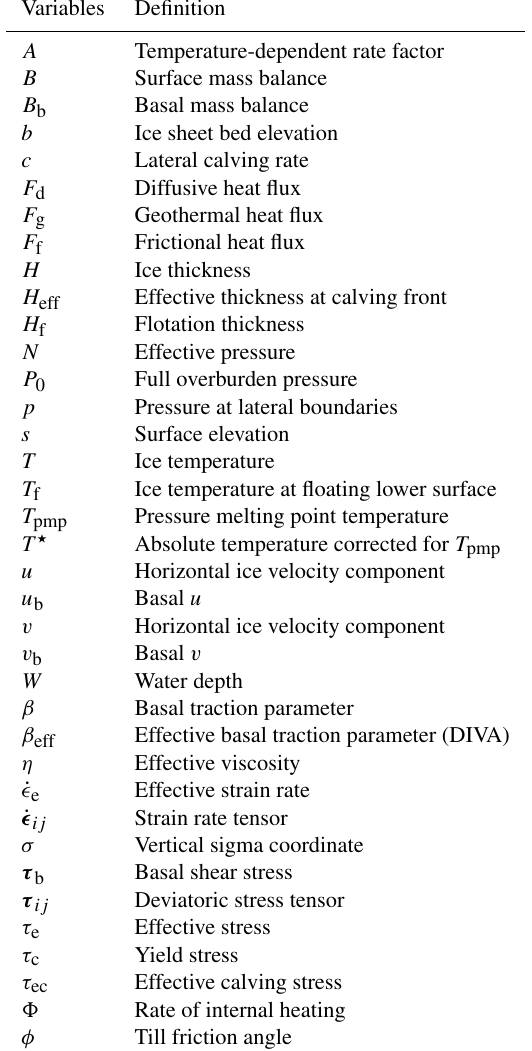
Table 1. Model variables defined in the